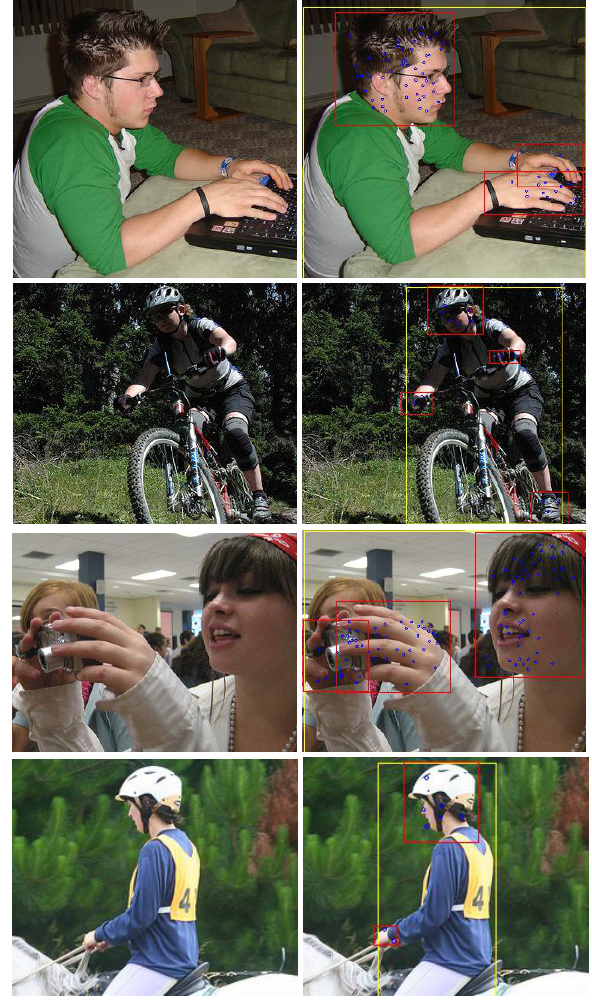
Figure 2. The processed person layouts with detected G-SURF